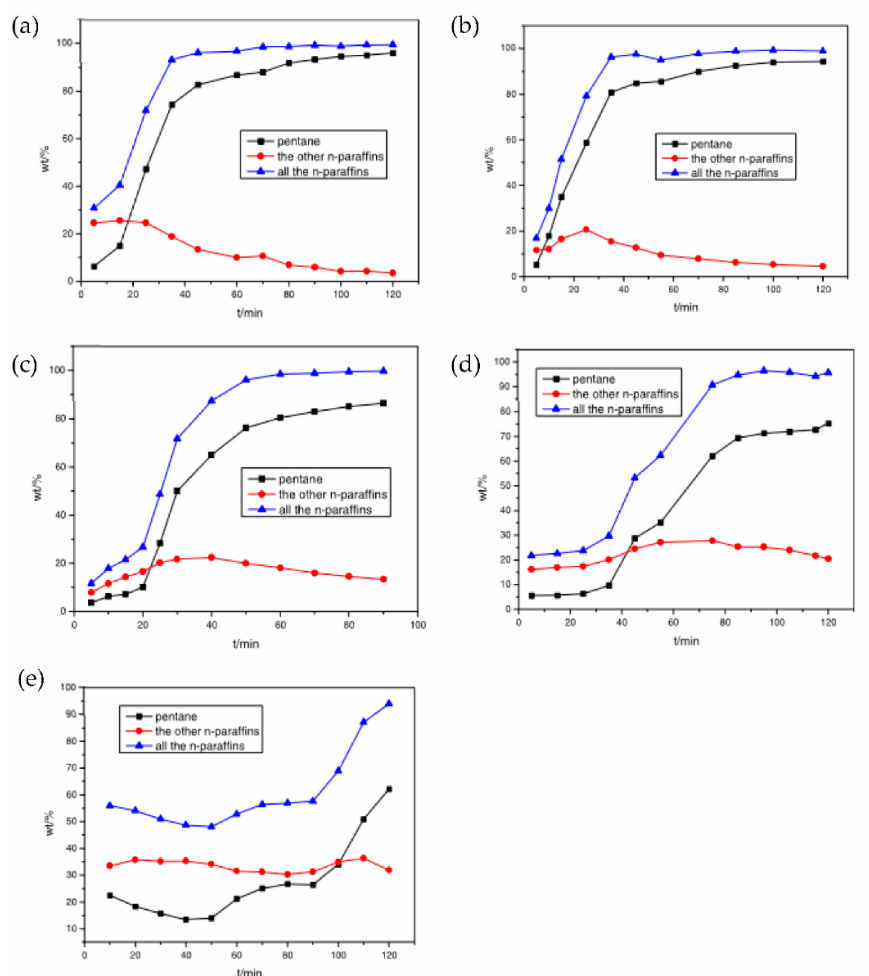
Figure 3. Relationship between desorption time and n-paraffin content at different space velocities [35]. passing through 5A catalyst per unit